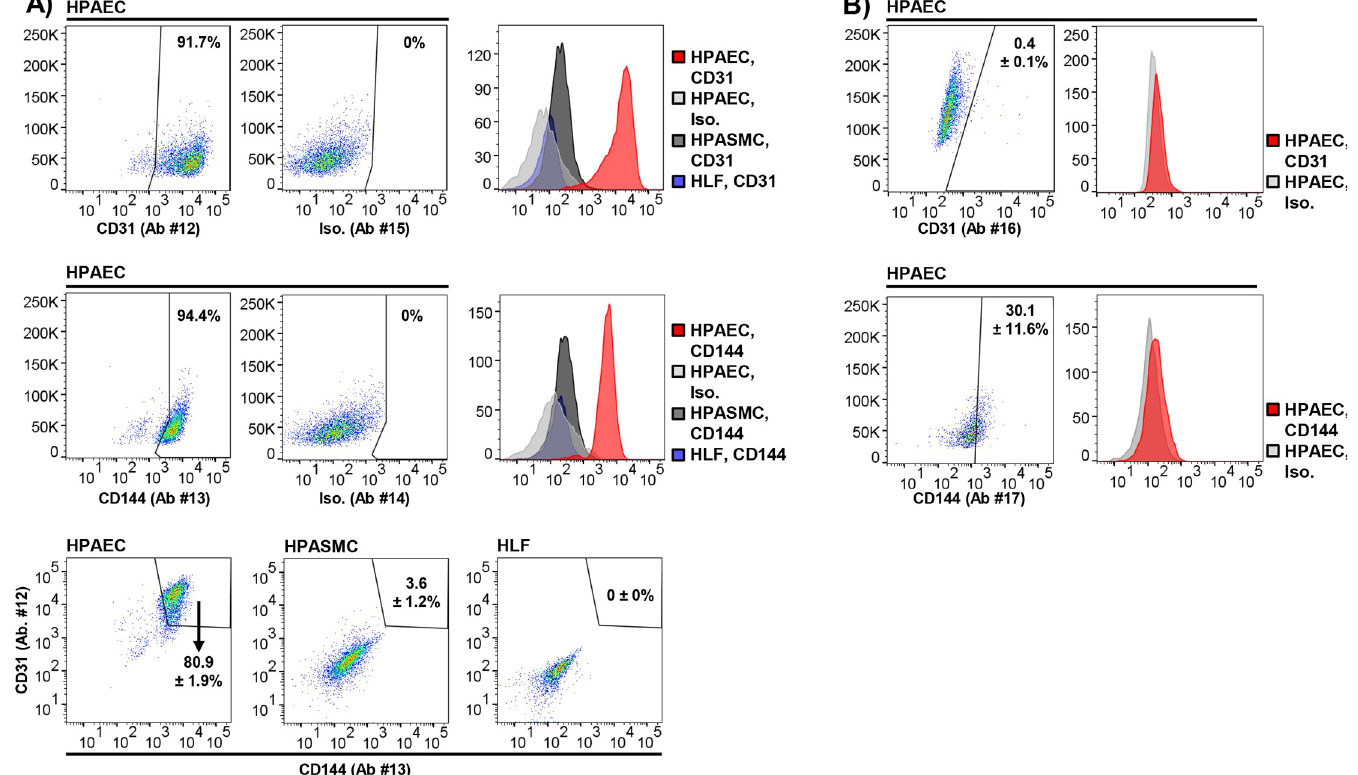
Fig 3. Identifying human pulmonary artery endothelial cells (HPAECs) by flow cytometry. (A) Commercially purchased HPAECs were analyzed by flow cytometry using anti-CD31 and anti-CD144 Abs #12 and #13. Compared with HPASMCs and HLFs, high expression of CD31 and CD144 was observed only in HPAECs. These results served as a positive control for further experiments aiming to confirm that cells isolated from rat lungs ex vivo were, in fact, endothelial. (B) Commercially purchased HPAECs were used to test the generalizability of these results. Alternative anti-CD31 and anti-CD144 antibodies did not reliably identify endothelial cell surface markers, supporting our earlier findings indicating variability in reactivity (i.e., quality) of tested antibodies across experimental methods, including flow cytometry. Representative plots and histograms shown. Means ± standard error, % CD31 or CD144 positive, N = 4-5/condition. Ab, antibody; Iso, Isotype control.